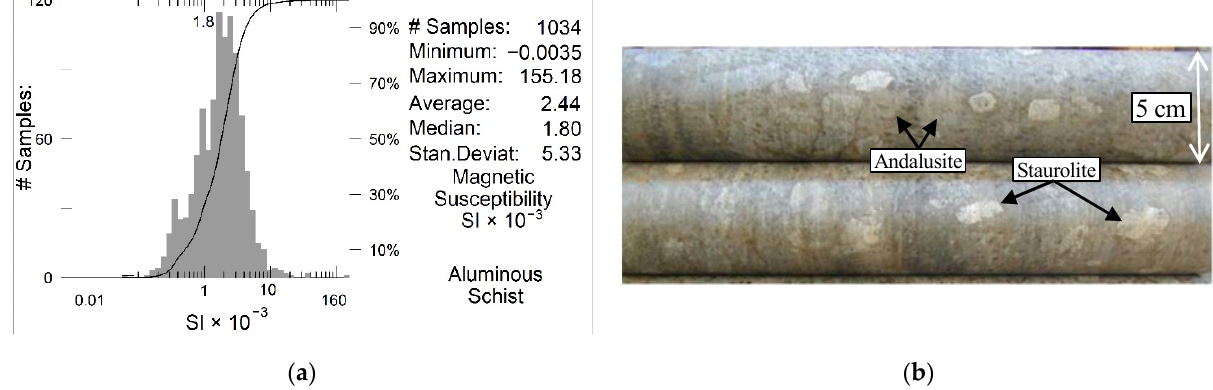
Figure 12. Aluminous schist. ( a ) Statistics and histograms of the magnetic susceptibility measurements. ( b ) Core samples picture.